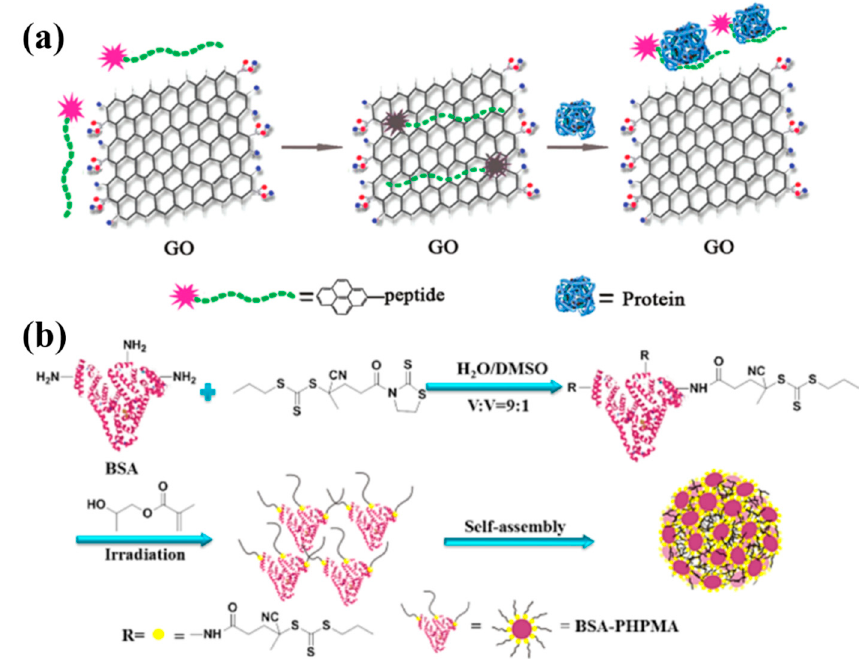
Figure 3. The hydrophobic interaction for biomolecular self-assembly: ( a ) A pyrene-labeled peptide for monitoring the protein–peptide interactions. Reprinted with permission from [71]. Copyright 2011 American Chemical Society. ( b ) Self-assembly of bovine serum albumin (BSA)-based nanoparticles to microspheres. Reprinted with permission from [72]. Copyright 2017 American Chemical Society. GO, graphene oxide.